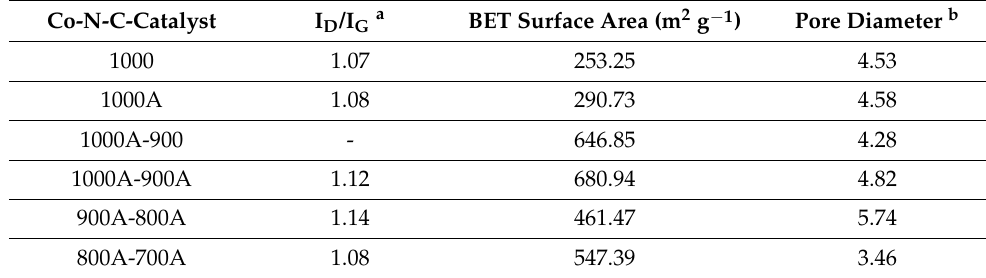
Figure 3. Raman spectra of various Co-N-C catalysts measured from 1000 to 2000 cm − 1 . Table 2. Comparison of various properties of Co-N-C catalysts.